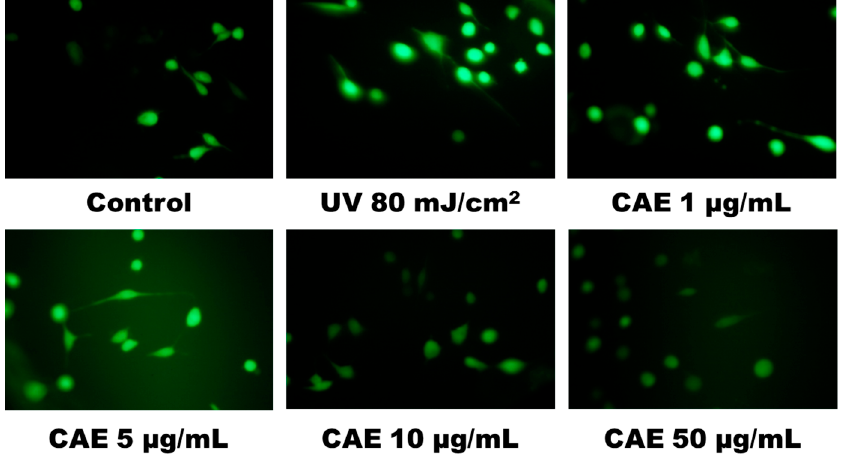
Figure 6. Examination of CAE inhibition of intracellular ROS generation in human skin fibroblasts by using a DCFH-DA assay (magnification factor: 200×). UVB irradiation increased ROS generation, whereas CAE inhibited ROS generation.